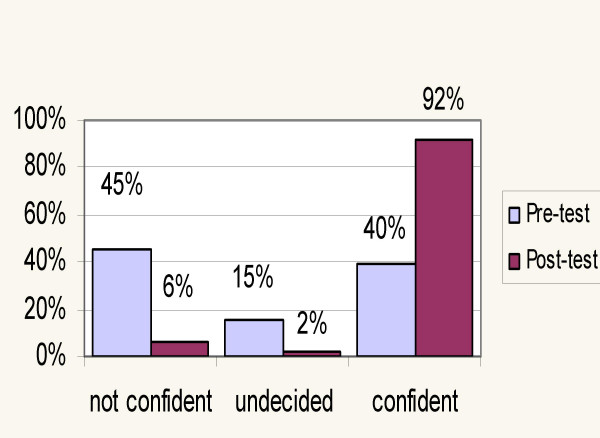
Deciding the steps to take with at-risk drinkers.